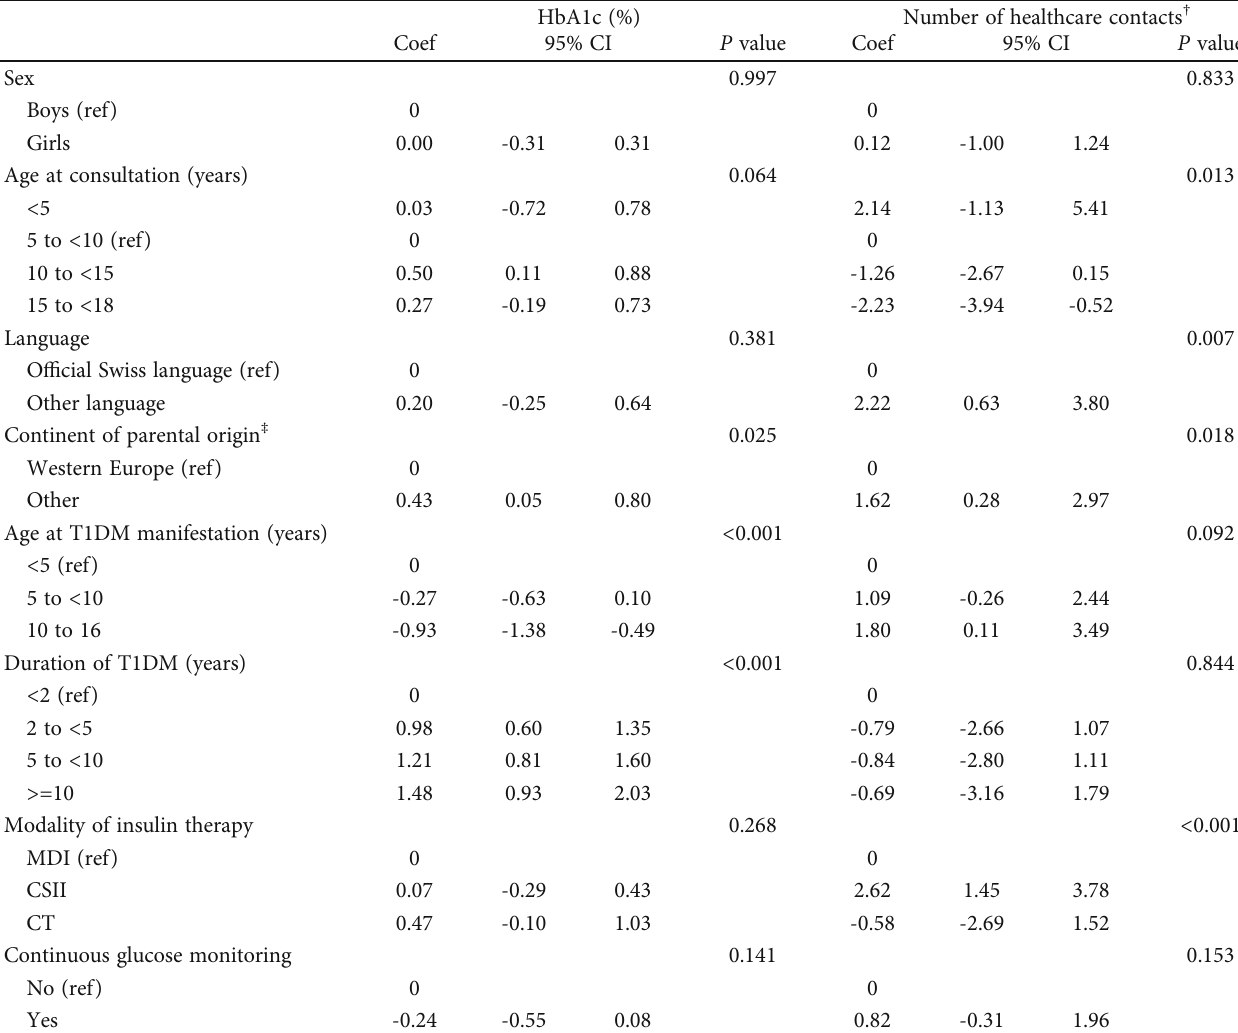
Table 2: In fl uence of sociodemographic, medical, and treatment-related factors on HbA1c concentrations and on number of healthcare contacts in patients with type 1 diabetes mellitus, results from linear regression adjusted for age at consultation and sex. Reference groups for comparison within categories are labelled with